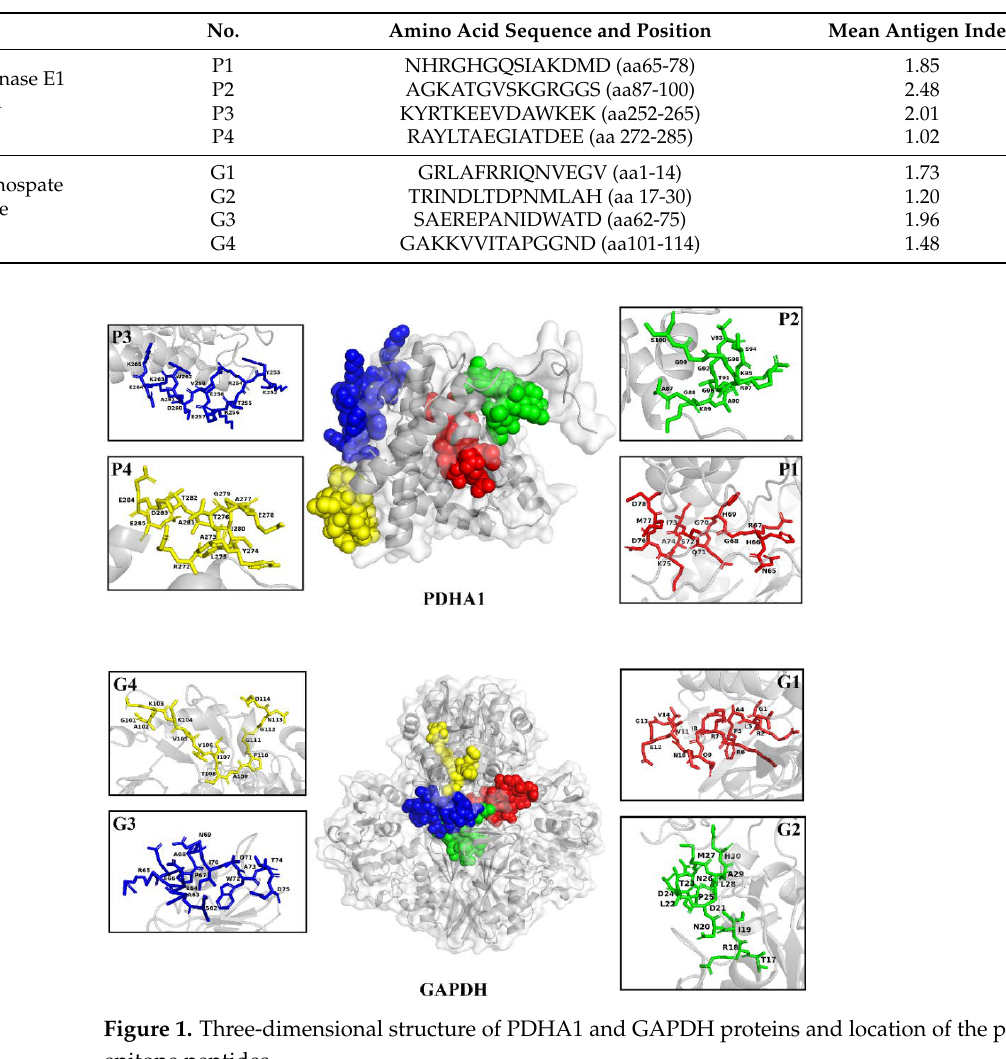
Table 1. The results of epitope prediction.